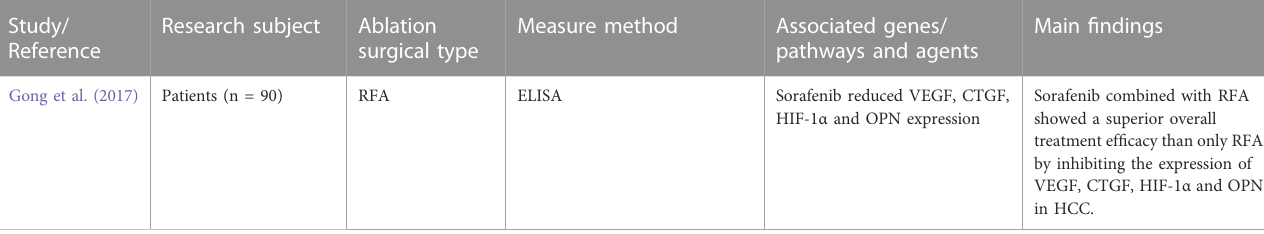
detoxi fi cation in mammals (Cziraki et al., 2020). It has two isoforms: arginase-1 and arginase-2, localized in the cytosol and mitochondria, (Alexander et al., 2020). The HIF well-studied target is the vascular endothelial growth factor A (VEGFA) (Palazon et al., 2017). It is the